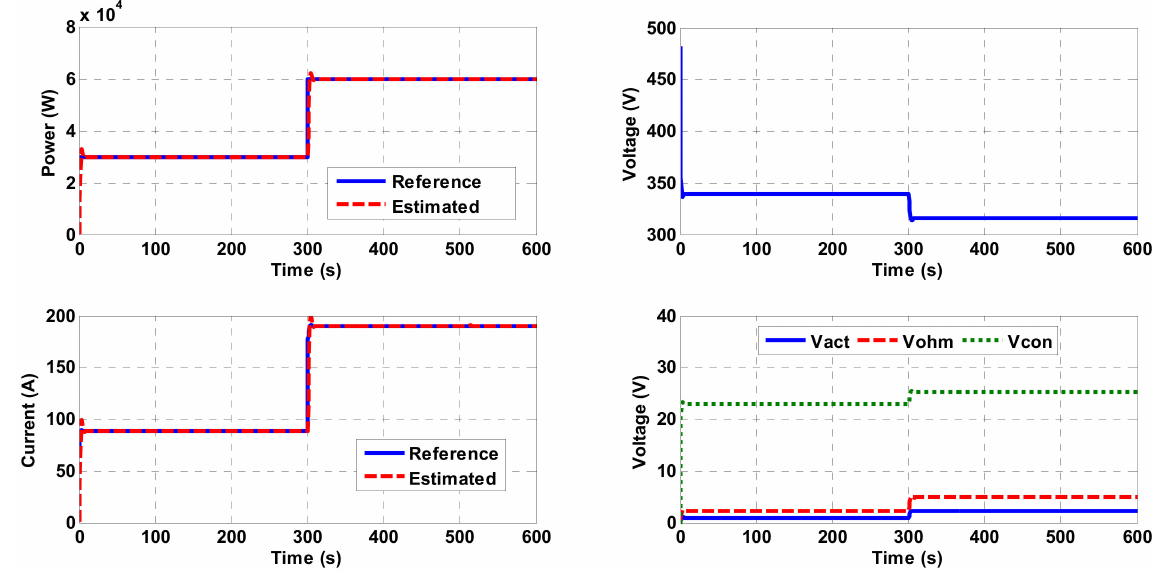
Figure 10. First load disturbance applied on SOFC stack dynamic model.